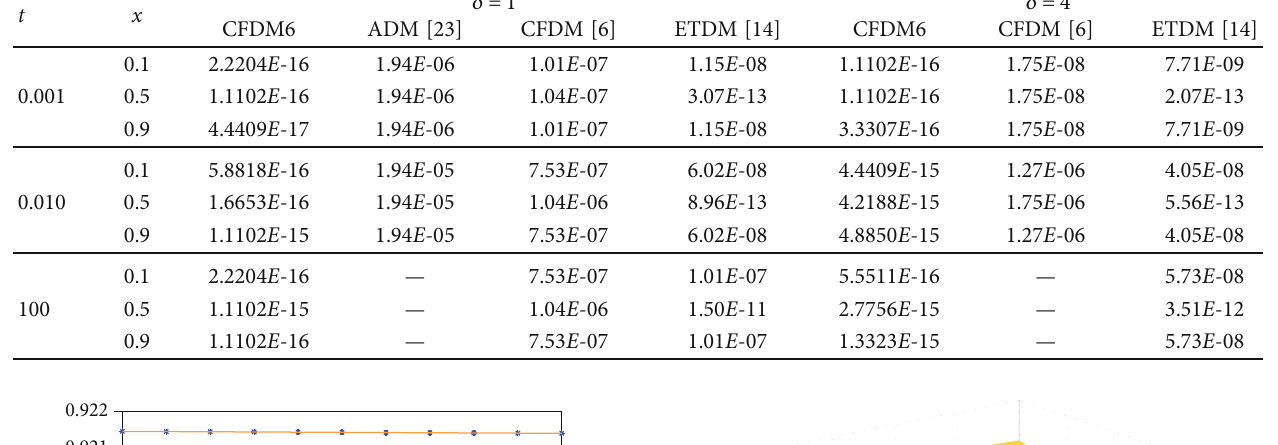
Table 1: Comparison of absolute error of Example 1 with β = 0 : 001 , γ = 0 : 001 , h = 0 : 1 , and Δ t = 0 : 0001 . t